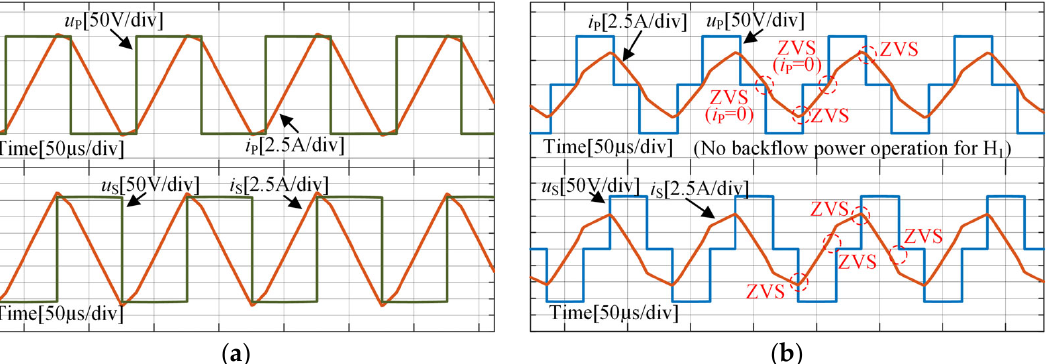
Figure 13. Steady ‐ state waveforms with two control methods in LCL resonant tank when U in = 80 V and k = 1.6. ( a ) SPS modulation; ( b ) Soft ‐ switching and no backflow power control.